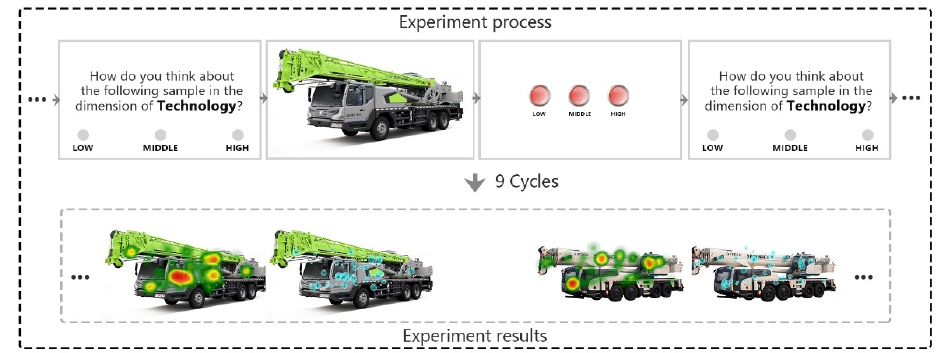
Figure 6. Partial visual trace of participants. Table 5. The mean score of each visual-interest region. Visual-Interest Region